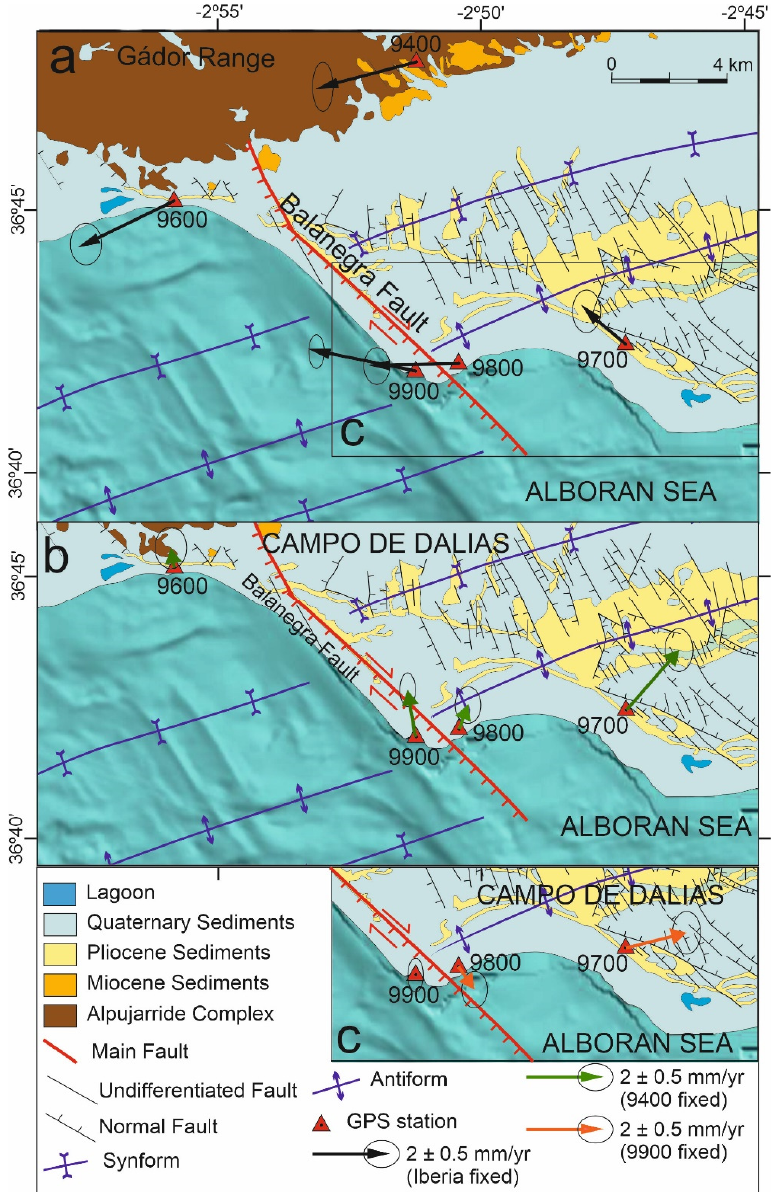
Figure 2. Geological sketch of the western Campo de Dalias, including residual GNSS velocities; error ellipses of 95% confidence: ( a ) Velocities with respect to stable Eurasia. ( b ) Velocities with respect to the relatively stable Site 9400 (Gador Range). ( c ) Velocities with respect to the relatively stable Site 9900 (southwest block of the Balanegra Fault).